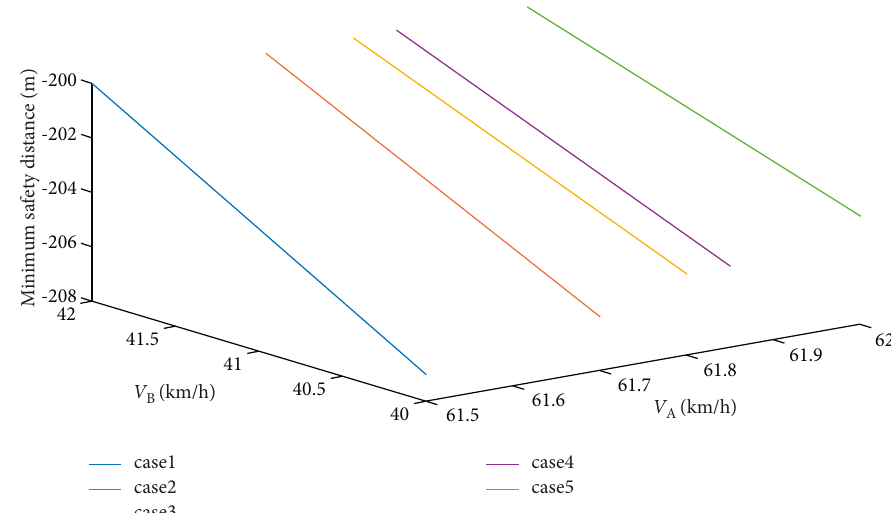
Figure 8: Minimum safety distance under uniform deceleration state of the front vehicle ( V